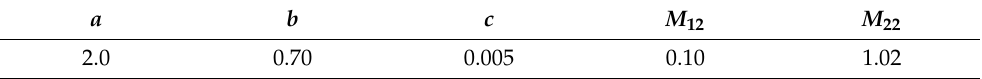
Figure 5. Fracture stage of an EK4 steel tensile sample. Table 3. Parameters of the Hosford-Coulomb damage criterion of the EK4 drawing steel.